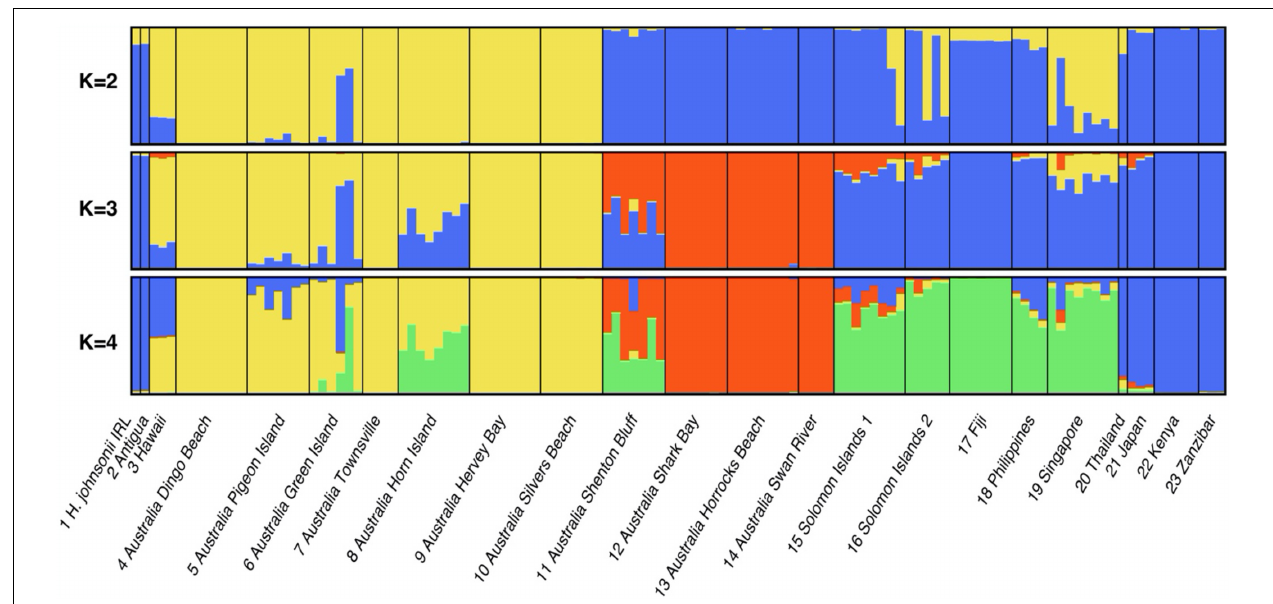
FIGURE 5 | Structure cluster assignment of H. johnsonii and H. ovalis “complex” populations for K = 2, K = 3, and K = 4 based on microsatellite genotyping. Each multilocus genotype is one vertical bar, populations are separated by black lines and cluster assignment is indicated by color. Population details can be found in Supplementary Table 5